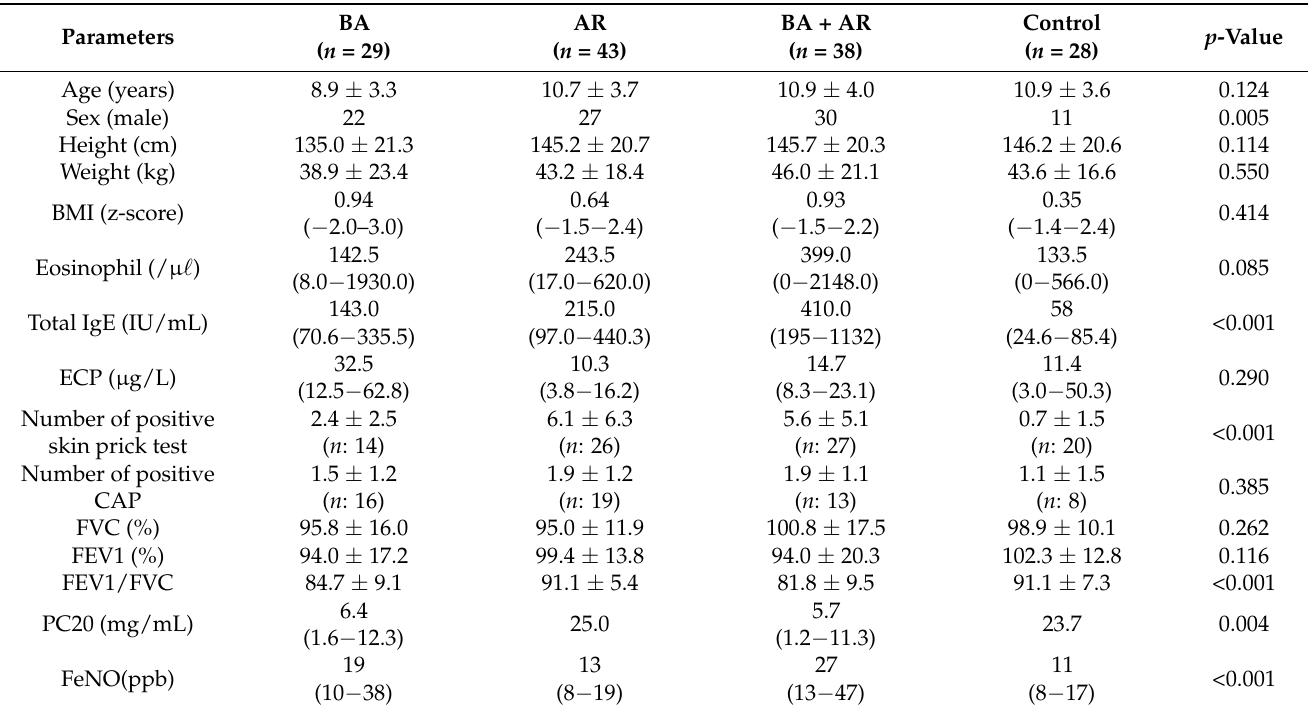
Table 1. Subject